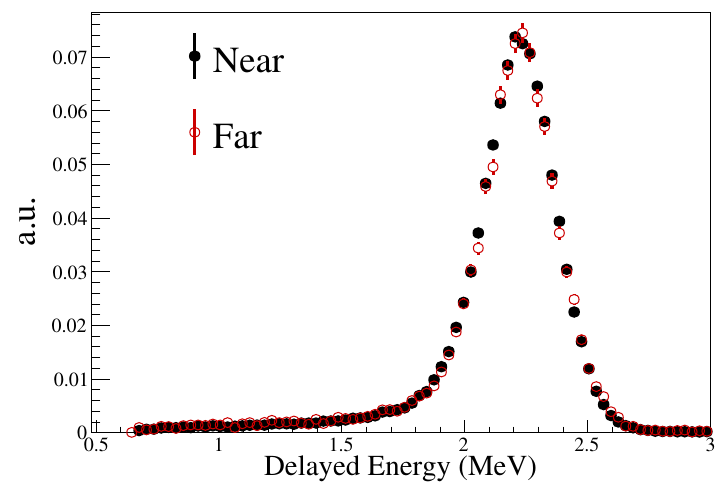
Figure 14 . Energy spectrum of delayed signal from neutron capture on hydrogen.